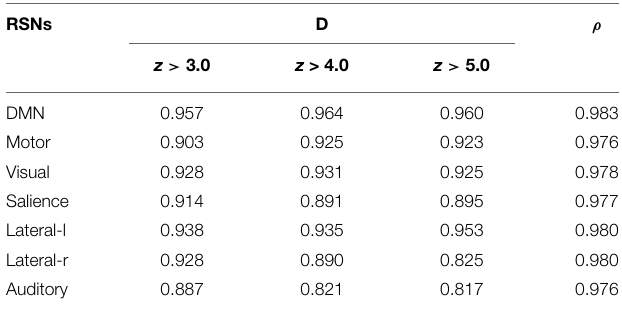
Values represent the Dice overlap coefficients (D) for multiple z -scores and a correlation metric ( ρ ) between the unthresholded maps. Analysis was performed on a single subject (S2) which was randomly selected.